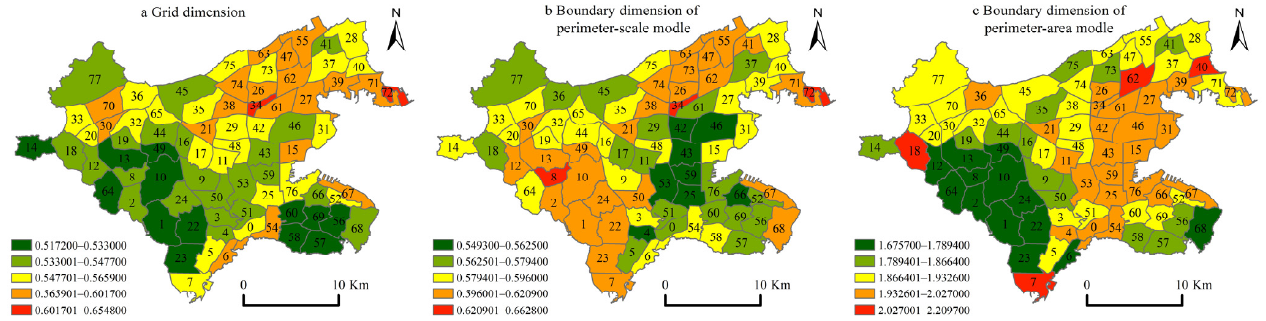
Figure 9. Spatial distribution of green space fractal characteristics of 78 blocks in Dalian. The grid dimension of the green space in 78 blocks of Dalian was between 0.5172 and 0.6548, and the fitted R 2 was greater than 0.996, showing that the fractal characteristics of the green space grid dimension at the block scale are obvious. The grid dimension represents the balance of the green space structure. The block with the highest grid dimension was No. 34, at 0.6548, indicating that this block had the highest balance of green space.